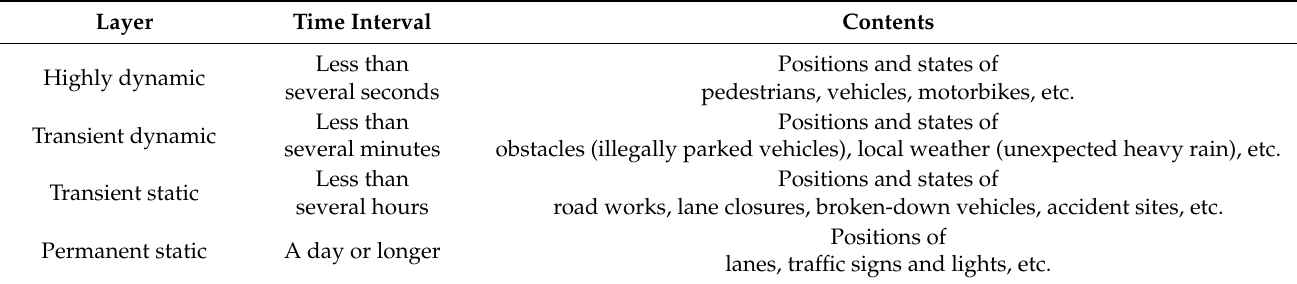
Table 3. List of layers comprising an LDM (adapted from